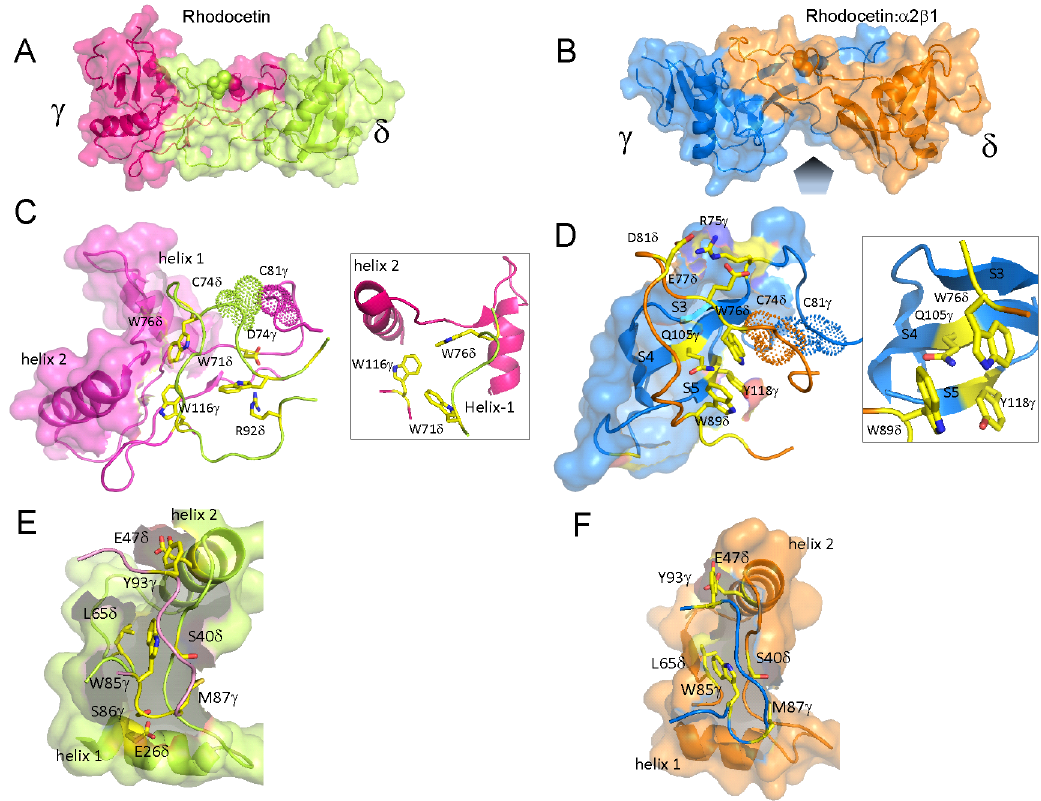
Fig 5. Conformational changes of RC γδ upon α 2A binding. Molecularsurface presentation showingthe dramatic globalconformational changesthat occur within the γδ subunitbetweenthe RC αβγδ tetramer ( A, C, E ) and the RC γδ - α 2A complex ( B, D, F ). The RC subunits γ and δ and their conformations are color-coded red ( γ ) and green ( δ ) for RC αβγδ and blue ( γ ) and orange( δ ) for the RC γδ - α 2Acomplex, respectively.( A ) and ( B ) Whereas the prospective bindingface towards α 2A (gray pentagonapproaching from the bottom in B ) was rather flat in RC αβγδ ( A ), RC adopted a concave surface towards α 2A upon formation of the RC γδ - α 2A complex ( B ). In the RC αβγδ tetramer ( C ), the loop δ – core γ interface is stabilizedby the 3 tryptophan residues, W116 γ , W71 δ ,and W76 δ , which form a stabilizingbutterfly structure together with a salt bridgebetweenR92 δ and D74 γ and a disulfidelink betweenC81 γ and C74 δ ,which is depictedas a dotted surface. ( D ) In RC γδ - α 2A,the index finger loop from subunit δ moves towards the antiparallelsheet S3–S4–S5of subunit γ . The disulfidebridgebetweenC81 γ and C74 δ (highlightedas spheresin [ A ] through [ D ]) is unaffected, but the stabilizingbutterfly is destroyedand replaced by a hydrophobic cluster of W76 δ , W89 δ ,and Y118 γ . In addition,a new salt bridgebetweenR75 γ and E77 δ and D81 δ is formed in place of the broken salt bridgebetween R92 δ and D74 γ . ( E, F ) A detailedview of the loop γ –core δ interactionas observedin RC αβγδ ( E ) and RC γδ - α 2A complex ( F ), respectively. In both cases, the interface is highly conservedand does not alter its conformation upon the transition from RC αβγδ to RC γδ - α 2A complex. The index finger loop residues of RC γ remain orientedtowards the same residuesof the bridgeelementbetweenboth helix 1 and helix 2 of the RC δ